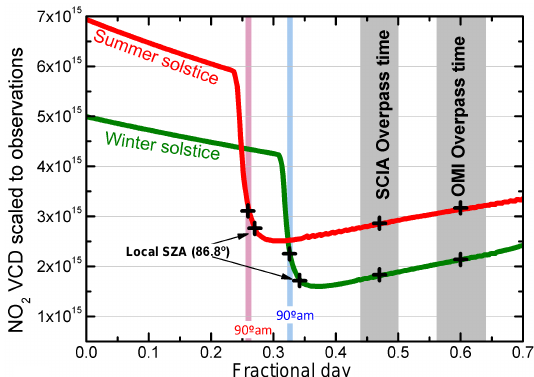
Figure 3. Example of the NO 2 photochemical behaviour from the SLIMCAT box model over Izaña. Red and green lines are the NO 2 VCD daily variation at the summer and winter solstices, respec- tively. Grey areas are the time overpasses of SCIAMACHY and OMI instruments (adapted from Gil et al.,